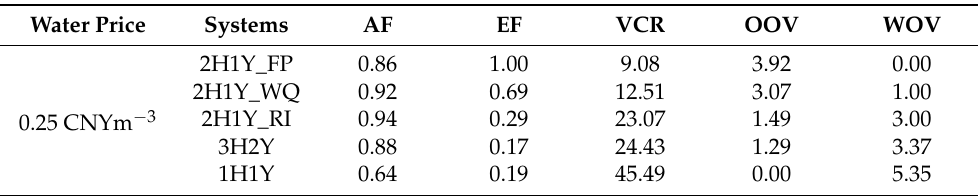
Table 7. Integrated evaluation indexes for selecting scenarios simulated by the WHCNS model under different cropping systems.